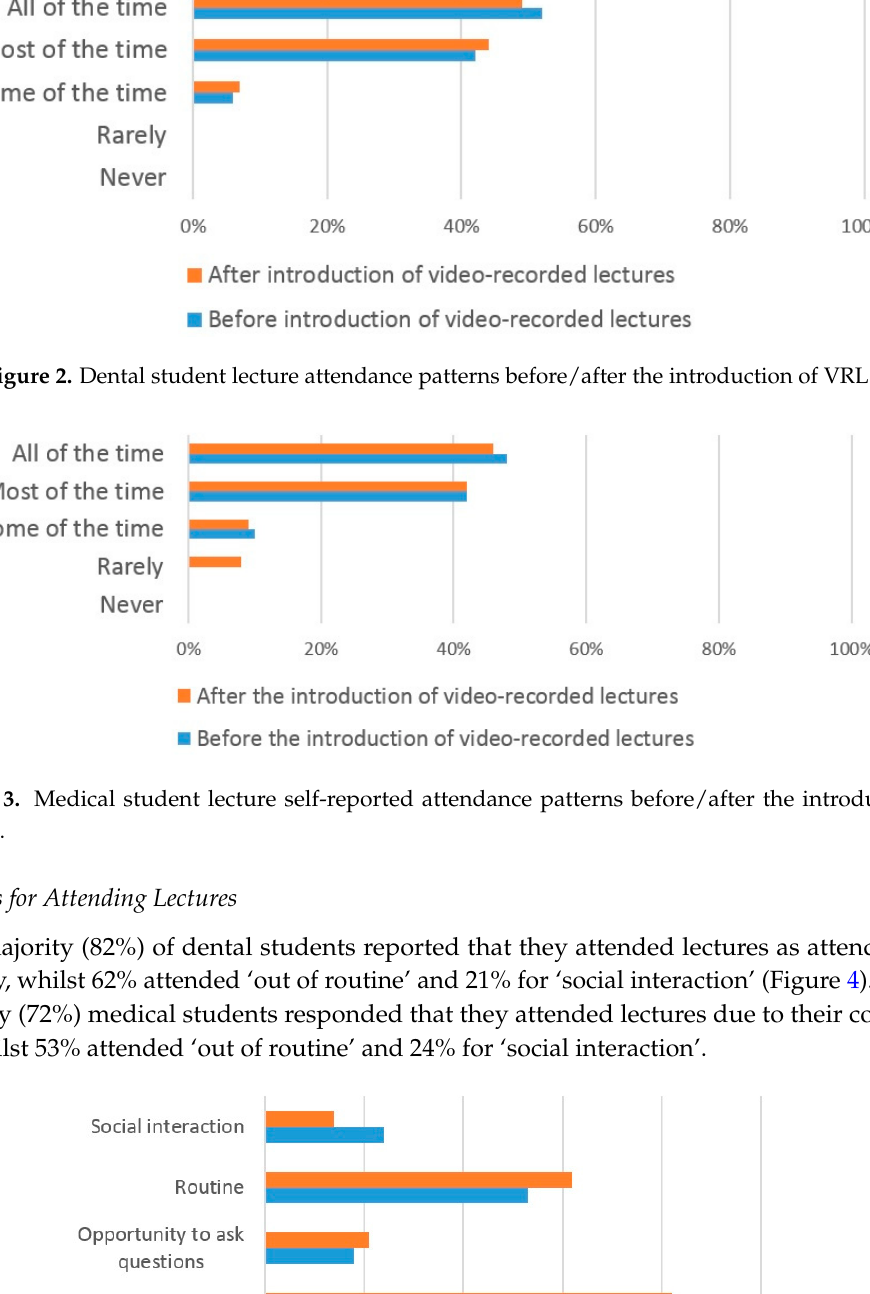
Figure 4. The reasons why dental and medical students attend lectures.